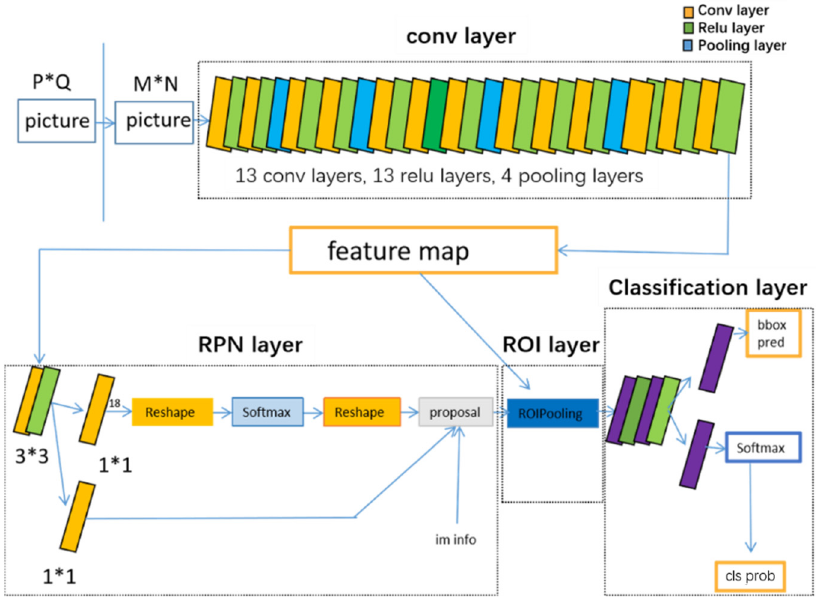
Figure 3. The block diagram of the Faster R-CNN network ( P and Q are the original length and width of the image, M and N are the length and width after network preprocessing).